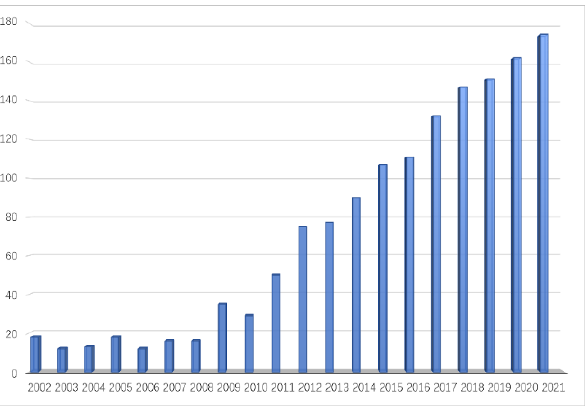
Figure 1. Microbial mass spectrometry imaging-related papers on Web of Science™ from 2002–2021.